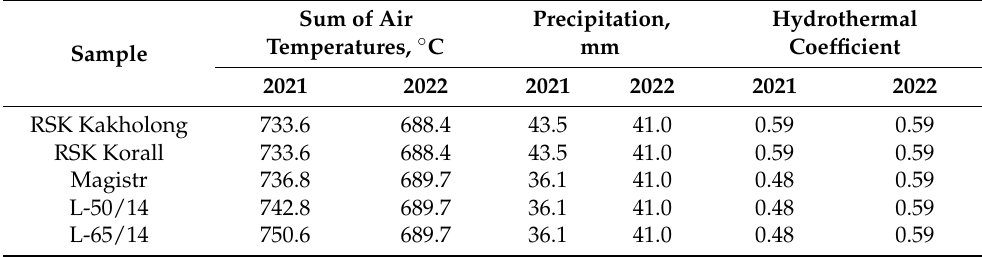
Table 1. Features of hydrothermal conditions 30 days before the flowering of sorghum